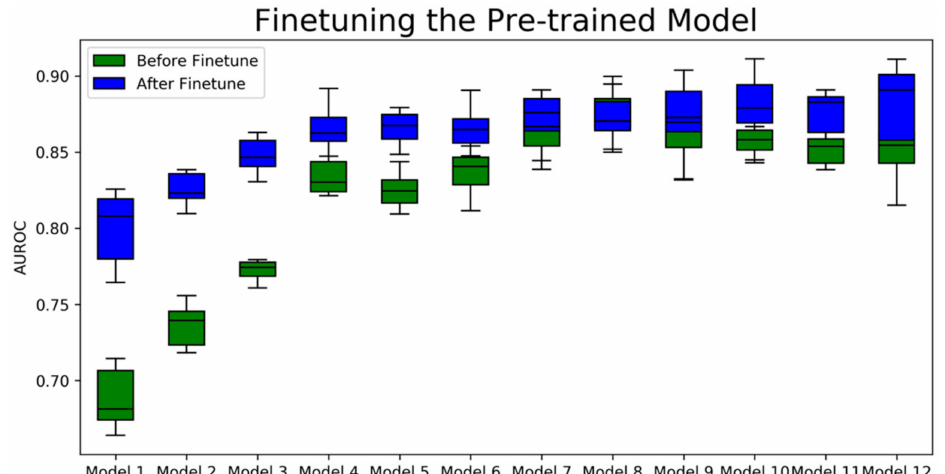
Figure 3. The average AUROC of the pre-trained models and fine-tuned models of the test set. Model 1 to model 12 are models that possess different sets of hyperparameters listed in Table 1. The green boxes are the distributions of AUROC scores computed from the random split test sets before finetuning the pre-trained models, and the blue boxes are the distributions of AUROC scores computed from the same random split test sets after 100 epochs of